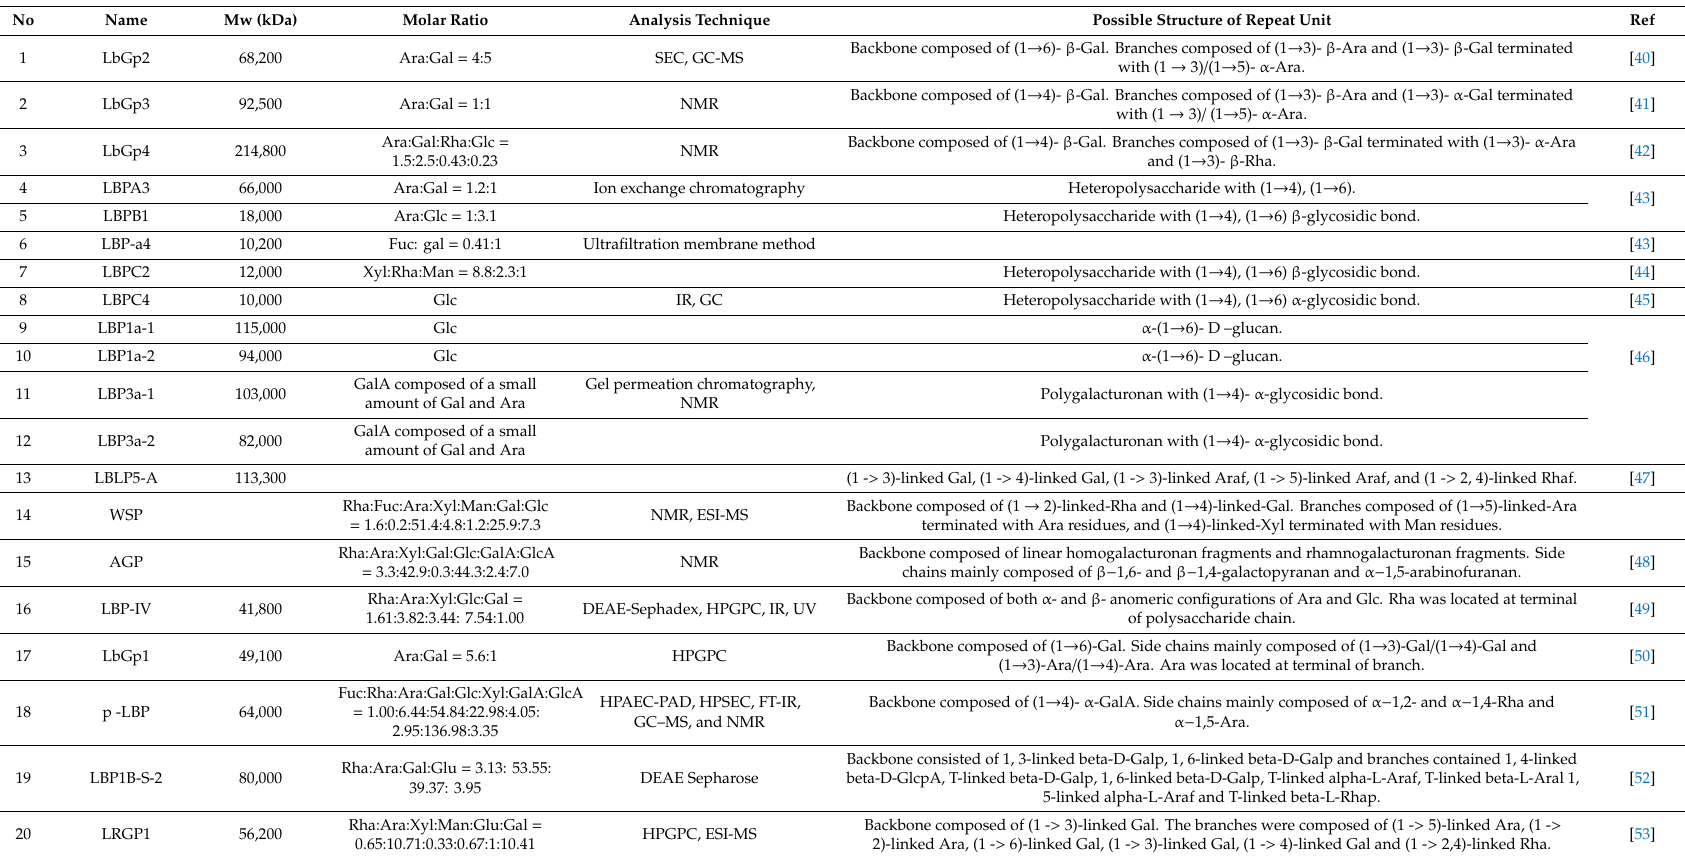
Table 2. The possible structure of repeat units, molecular weights, and analysis technique of polysaccharides in L. barbarum [39] . Definitions: SEC = size exclusive chromatography, GC–MS = gas chromatography–mass spectrometry, NMR = nuclear magnetic resonance, IR = infrared, GC = gas chromatography, ESI-MS